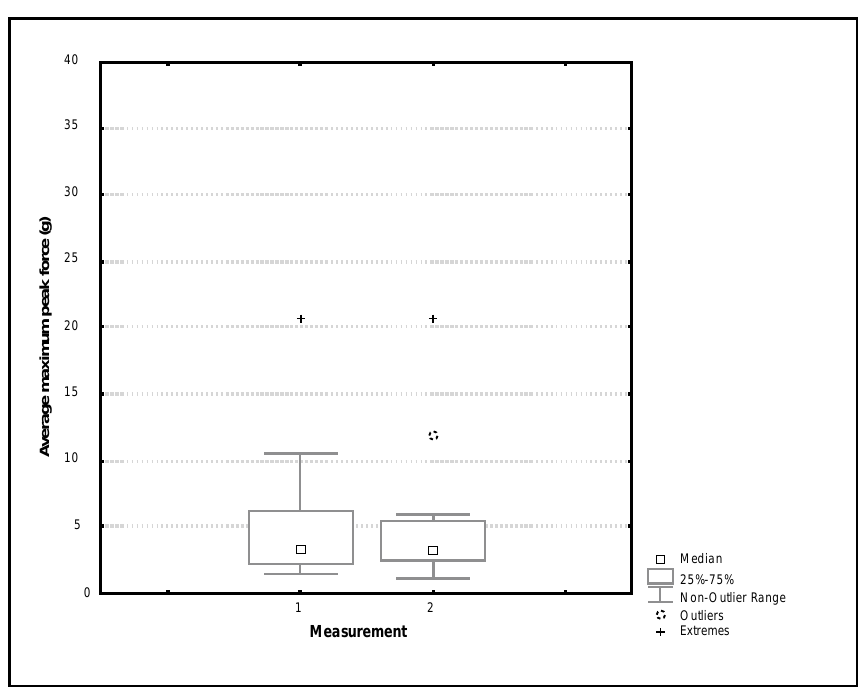
Figure 3: The average maximum peak force during a grade I p-a pas- sive mobilization technique on C6, applied by the entire group of phy- siotherapists during the first and second